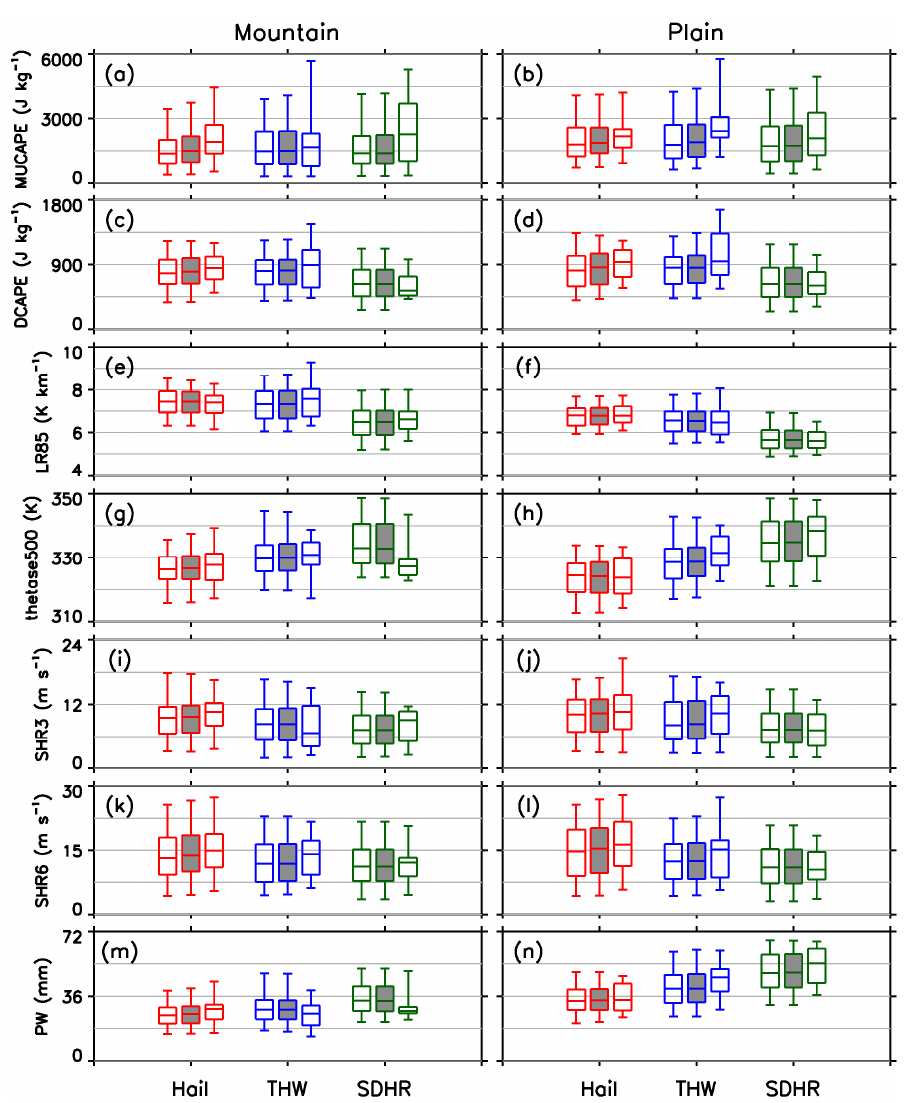
Figure 8. Box-and-whisker plots of the environmental parameters associated with three types of severe convective events with different severities over the ( a , c , e , g , i , k , m ) mountains and ( b , d , f , h , j , l , n ) plains. Hail, THW, SDHR events are indicated in red, blue, and green, respectively. The box-and-whiskers filled with grey denote all events in this category while those on the left (right) denote ordinary (significant) events. Parameters include: ( a , b ) MUCAPE, ( c , d ) DCAPE, ( e , f ) LR85, ( g , h ) thetase500, ( i , j ) SHR3, ( k , l ) SHR6, and ( m , n ) PW. The 5th, 25th, 50th, 75th, and 95th percentiles are